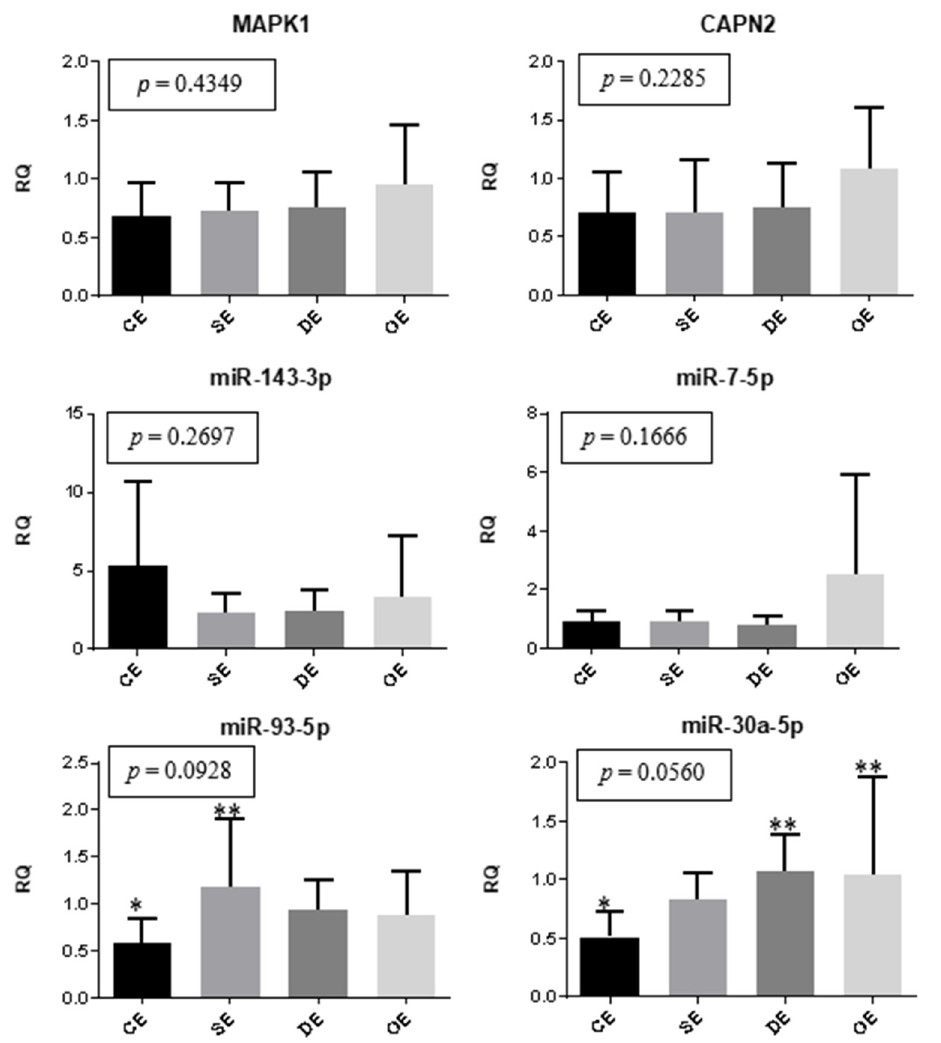
Figure 3. Eutopic endometrium. Representation of the mean ( ± standard error) gene and miRNA expression in the eutopic endometrium of women with superficial peritoneal endometriosis (SE) ( n = 10), deep infiltrating endometriosis (DE) ( n = 10), ovarian endometrioma (OE) ( n = 10), and the control eutopic endometrium (CE) ( n = 10). The groups highlighted with * and ** showed statistically significant differences in the Tukey post-hoc test.